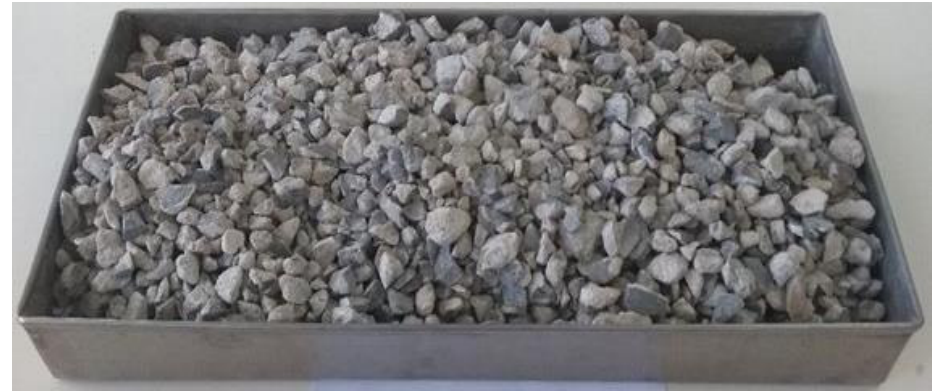
Table 1. Chemical composition, physical properties, and mechanical performance of the types of cements used.